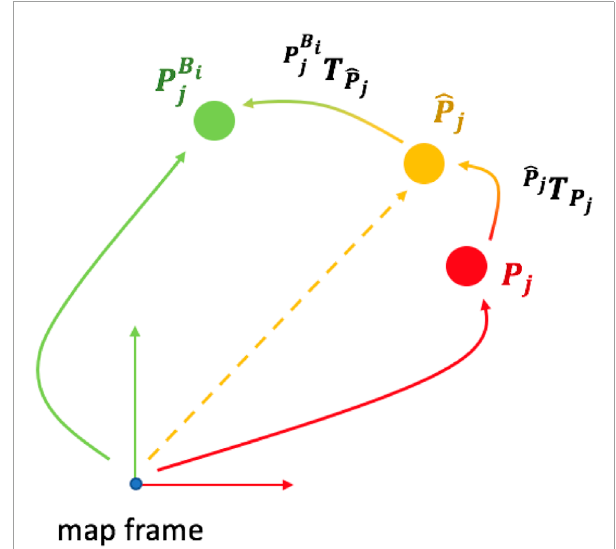
FIGURE 5 First, we find the correct position of the robot ̂ P j , w.r.t. OSM